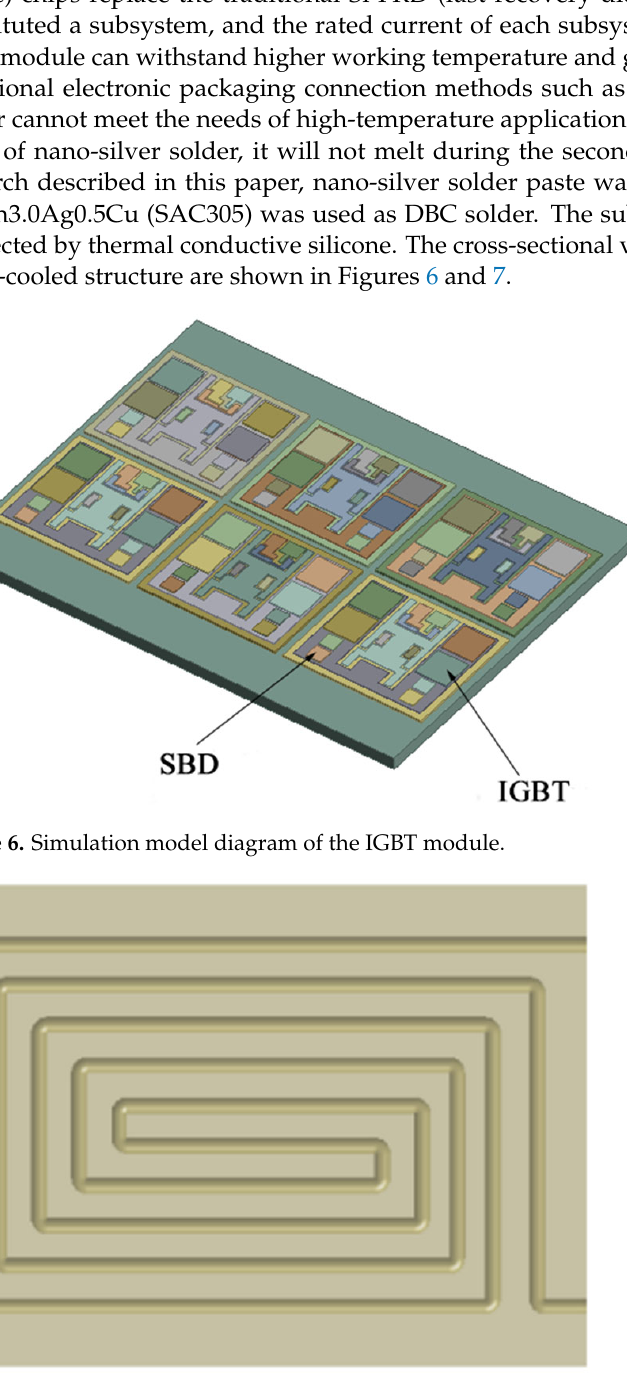
Figure 7. Structure diagram of the water-cooled heatsink.